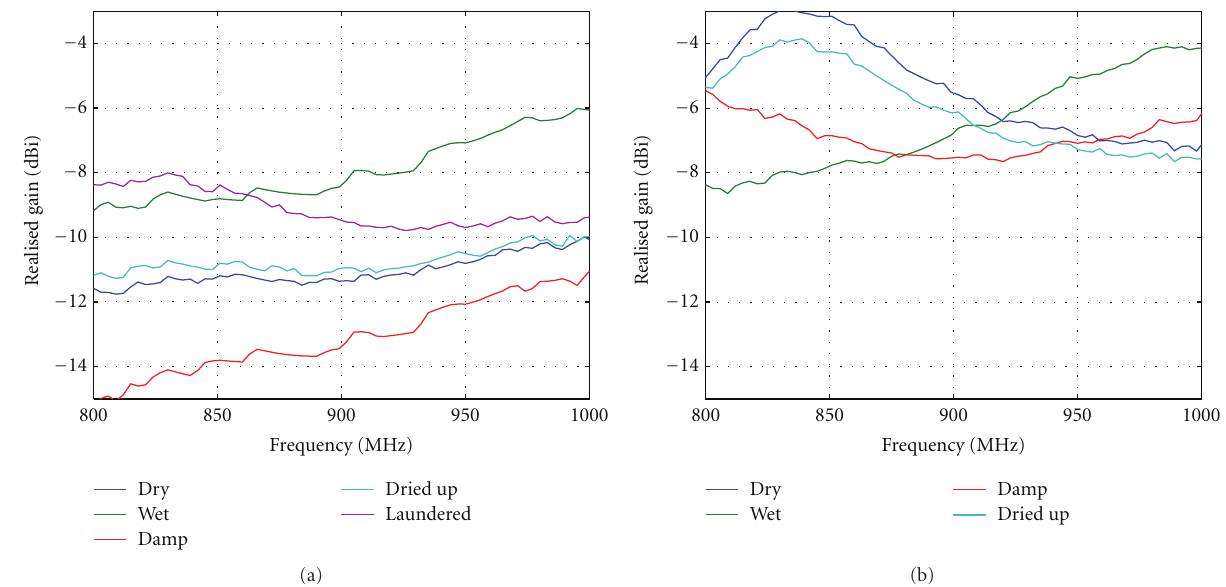
Figure 7: Realised gains of the tags measured before and after soaking, damp, dried up again, and after laundering (if available). (a) Acrylic coated tag; (b) silicone coated tag; both on Fabric (A).